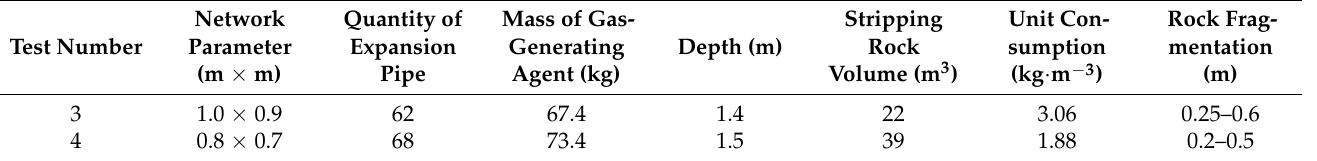
Table 5. Results of upper step excavation tests.